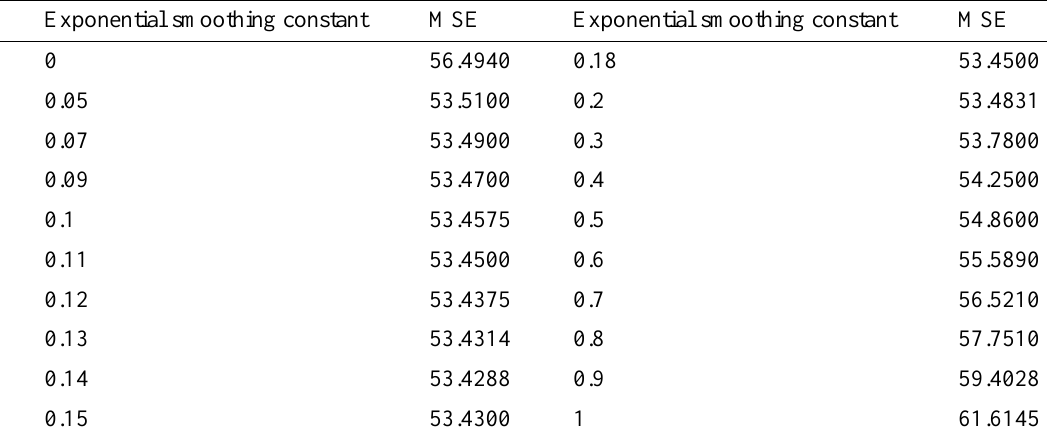
Table 3. MAD for different values of